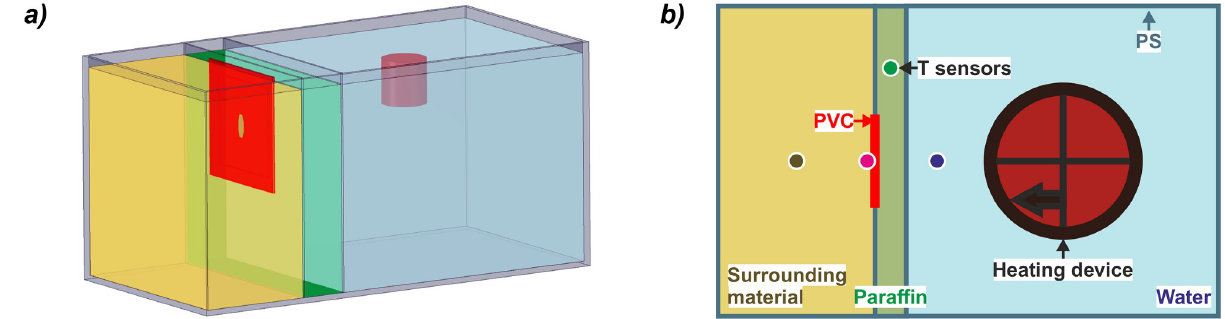
Fig 4. (a) Sketch and (b) top view of leakage experiments. Green: paraffin wax, blue: water, red: PVC layer, yellow: surrounding material. Sensor positions marked with dots. PVC: polyvinylchloride, PS: polystyrene glass plates.